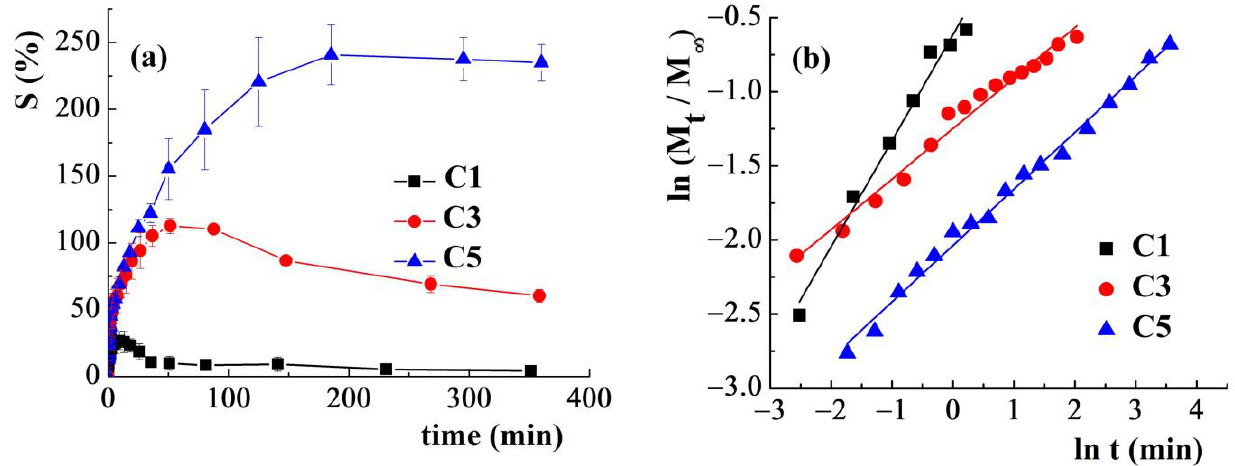
Figure 9. ( a ) Swelling degree, S, vs. immersion time in the water at room temperature and ( b ) the plots of ln(M t /M ∞ ) as a function of ln t for CS/PEG films with/without Lap.